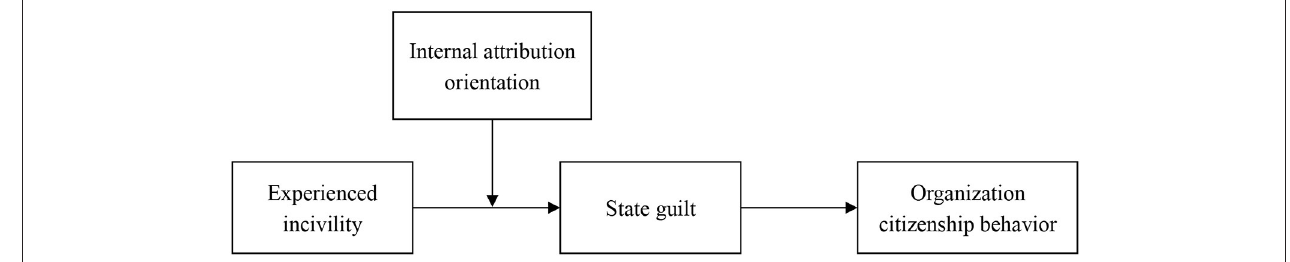
FIGURE 1 | Theoretical